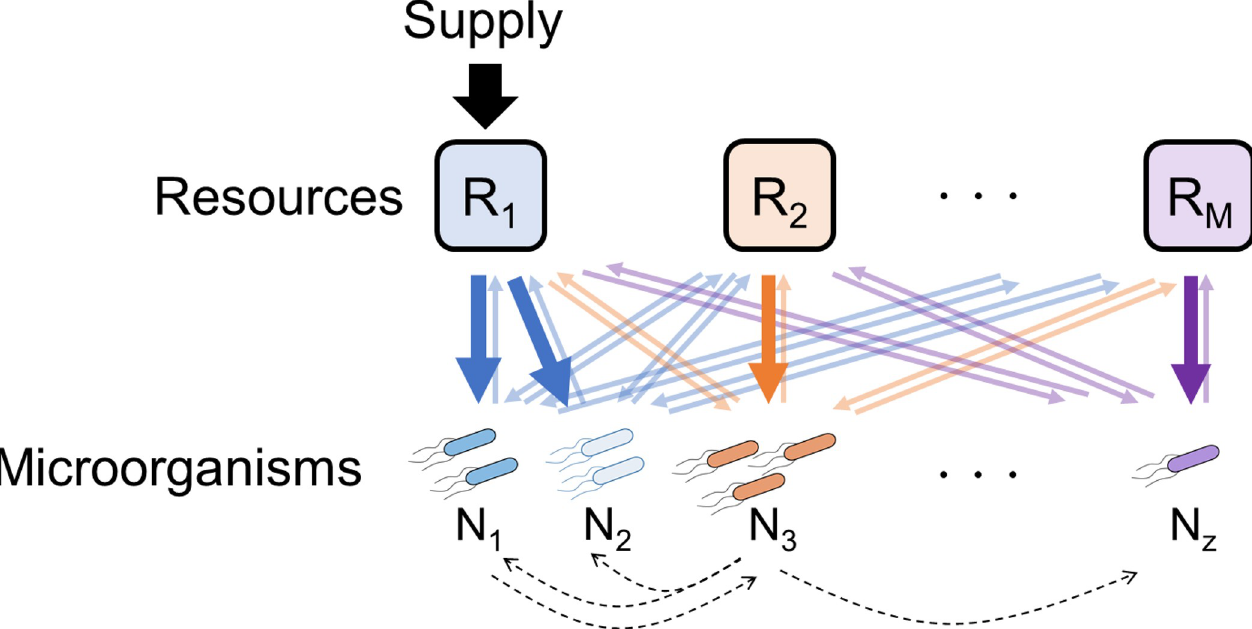
Fig 2. In silico model design. Each microbial species uptakes resources and secretes metabolic byproducts. Arrows from resources to microbial species indicate resource uptake and opposite arrows indicate secretion of metabolic byproducts. All resources are associated with specialized microbial species, as indicated by thick arrows. Each microbial species has essential symbiotic microorganisms, indicated by dashed arrows. For example, the metabolism of the microbial species N 1 is activated by the existence of microbial species N 3